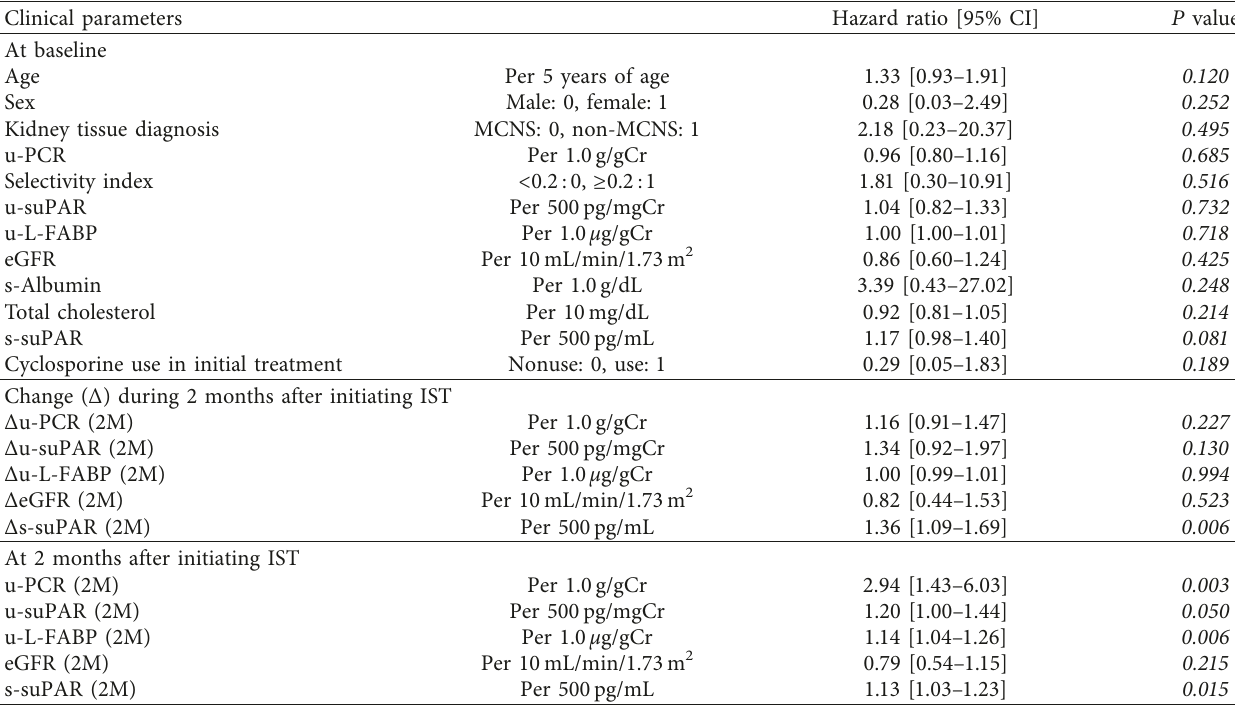
Table 2: Univariate Cox proportional hazard regression analysis for prediction of the time to 40% reduction in the eGFR. Clinical parameters